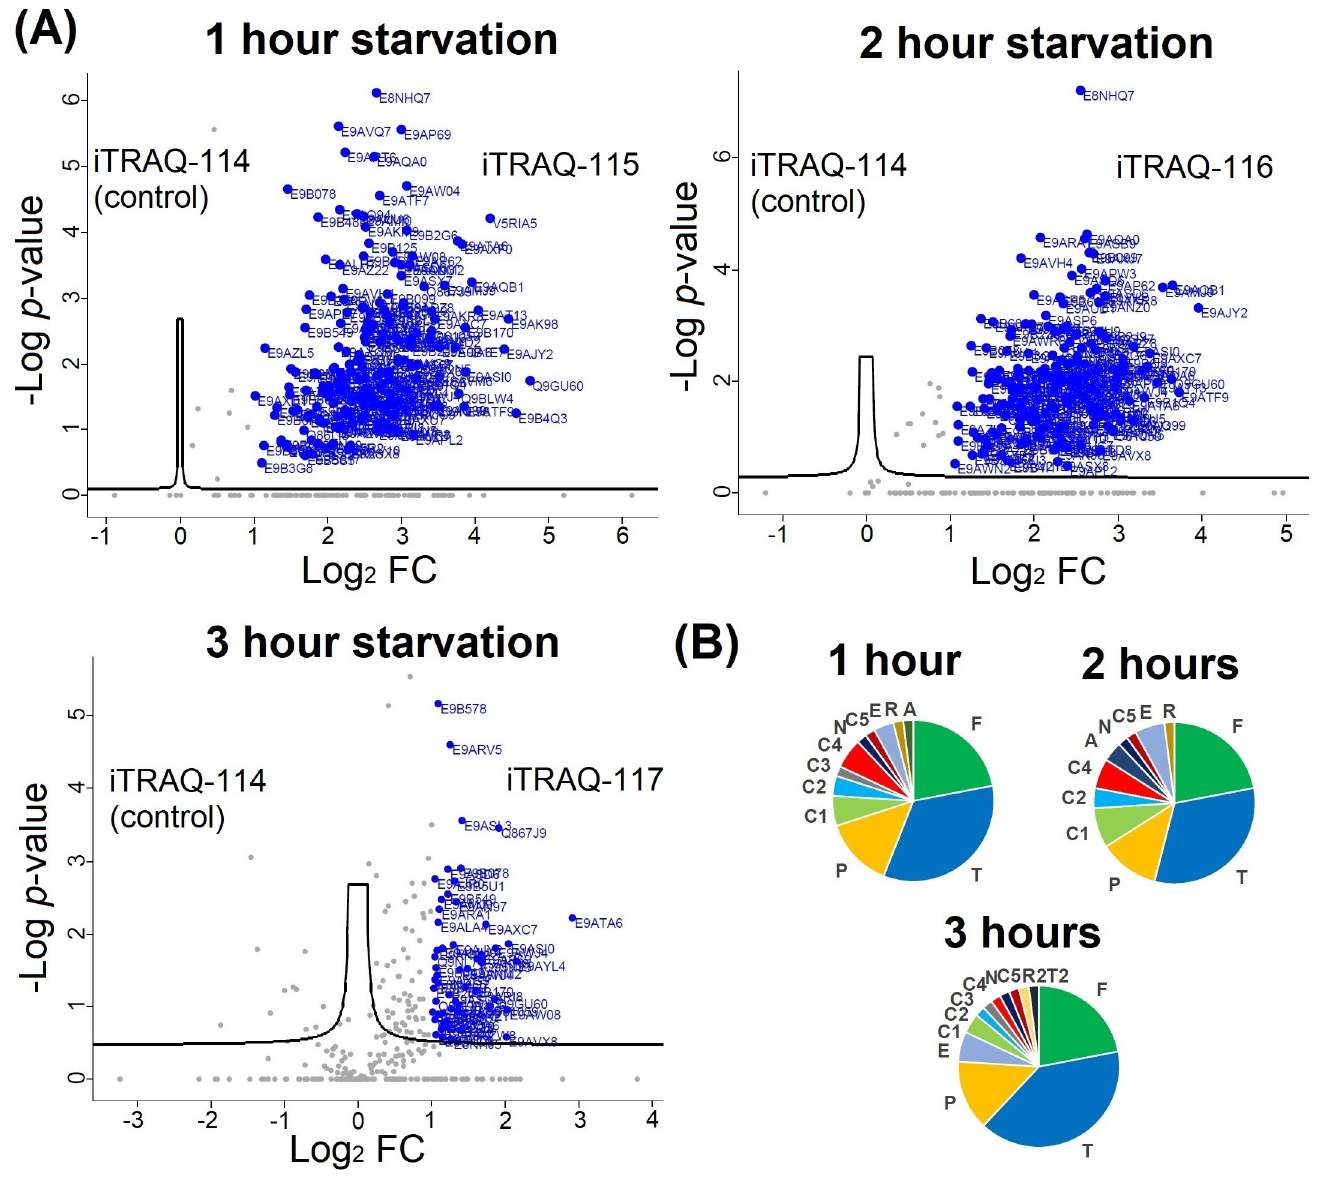
Fig 4. iTRAQ 4-plex quantitative proteomics MS profiling of NSPs of L . mexicana promastigotes during starvation. ( A ) Volcano plots of the NSPs detected at the three durations of starvation. The significance of the iTRAQ reporter intensities obtained for each NSP at each tested duration of starvation across two replicates as -Log P-values was plotted against the observed fold change (FC) in abundance in log2 scale. Proteins with a log2 FC of more than 1 with significant iTRAQ quantifications are highlighted in blue. ( B ) Functional annotation pie chart of the top-50 NSPs. The letter codes used for the functional categories are the following. (T) Translation, ribosomal structure and biogenesis; (F) Function unknown; (P) Post-translational modification, protein turnover, and chaperones; (A) Amino acid transport and metabolism; (C1) Carbohydrate transport and metabolism; (C2) Coenzyme transport and metabolism; (C3) Chromatin structure and dynamics; (C4) Cytoskeleton; (C5) Cell wall/membrane/envelope biogenesis; (R) Replication, recombination and repair; (R2) RNA processing and modification; (N) Nucleotide transport and metabolism; (T2) Transcription; (E) Energy production and conversion.